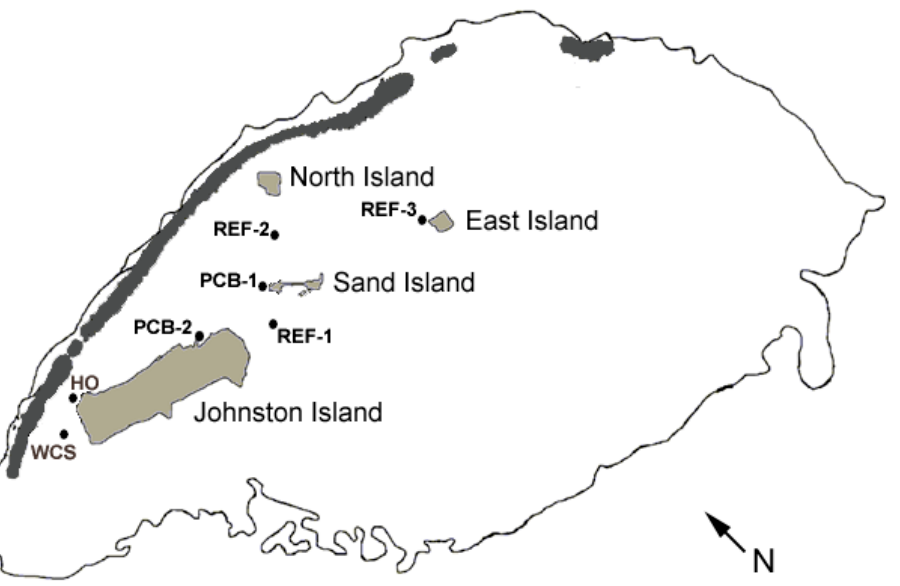
Figure 1. Schematic map of the Johnston Atoll study sites. The atoll is outlined at the 10-fathom contour. Islands are shaded light gray and emergent reef is shaded dark gray. Study sites were: PCB-1, the West end of Sand Island; PCB-2, the former Navy pier lagoon; REF-1, the channel margin adjacent to Buoy 14; REF-2, the sunken tug boat; REF-3, the western corner of East Island; HO, offshore from the former herbicide orange storage area; and WCS, where sediment samples were taken for comparison. For scale, Johnston Island is 2 miles in length.